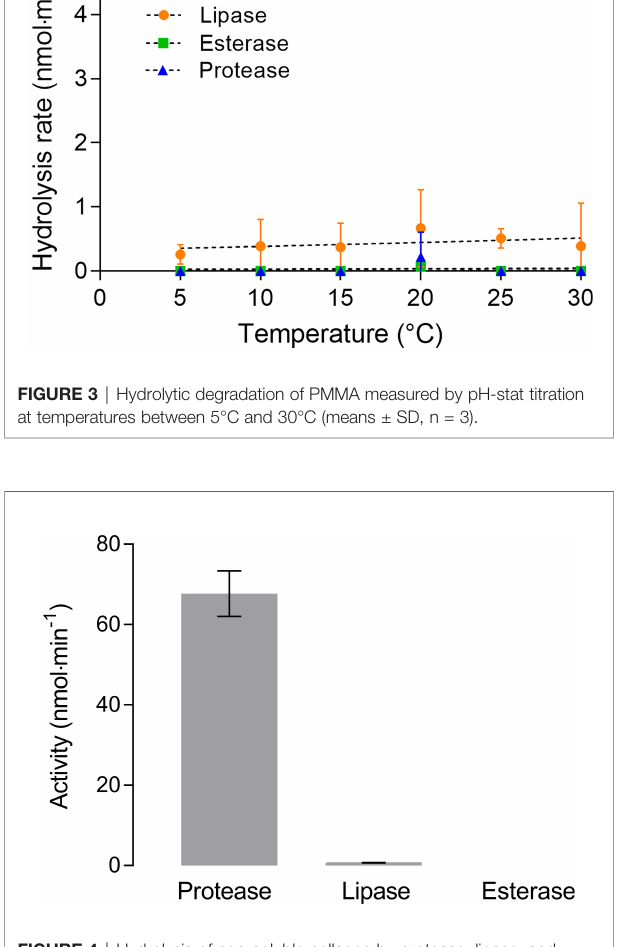
FIGURE 4 | Hydrolysis of non-soluble collagen by protease, lipase, and esterase measured by pH-stat titration at 20°C (means ± SD, n = 3).